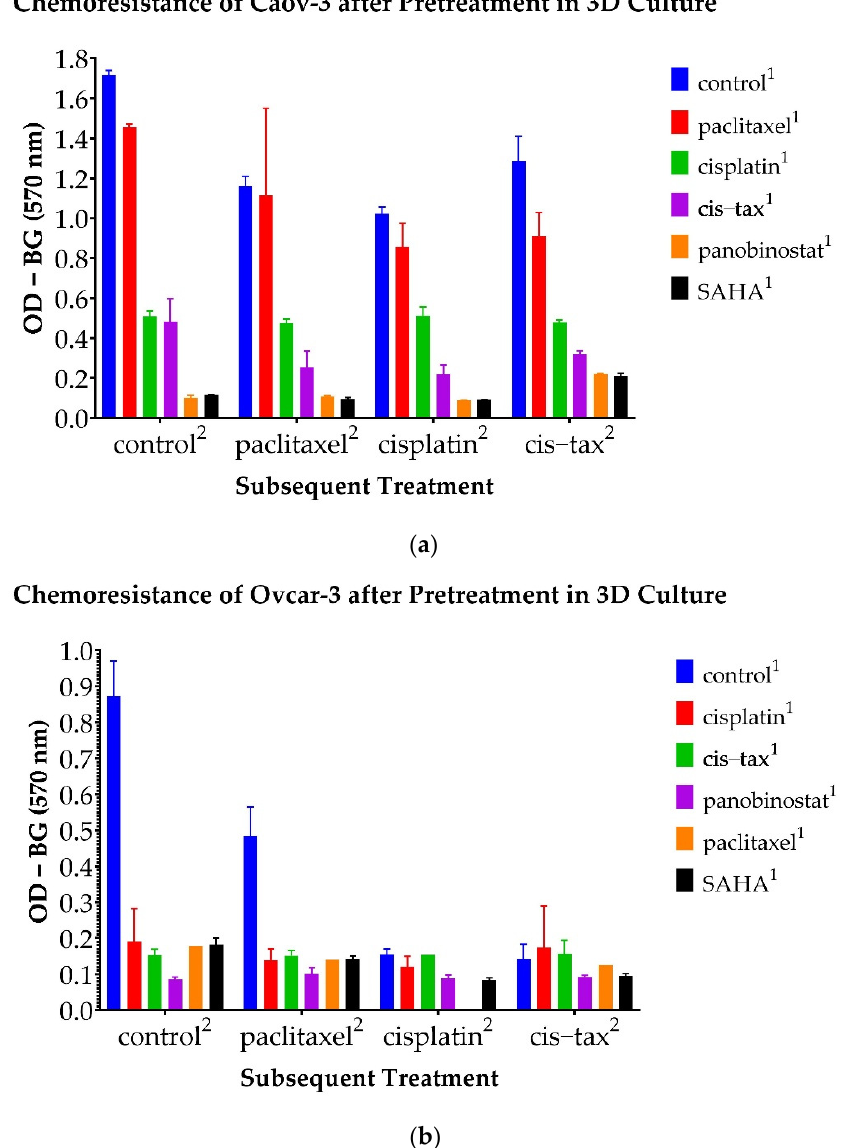
Figure 12. Optical density of ovarian cancer cells following a second round of classic chemotherapy. Spheroids were pretreated with a DMSO control, paclitaxel, cisplatin, cisplatin–paclitaxel, panobinostat and SAHA. They were then collected following primary treatment (denoted with the superscript “1”) and retreated with a subsequent treatment (denoted with the superscript “2”). Optical density was measured at 570 nm minus the background. ( a ) Caov-3 cells pretreated with panobinostat and SAHA demonstrated sustained chemosensitivity when retreated with classic chemotherapy ( p < 0.001). ( b ) All Ovcar-3 cells were somewhat resensitized to chemotherapy after one treatment; however, panobinostat and SAHA were the most effective in reversing chemoresistance ( p < 0.001) ( n = 2).